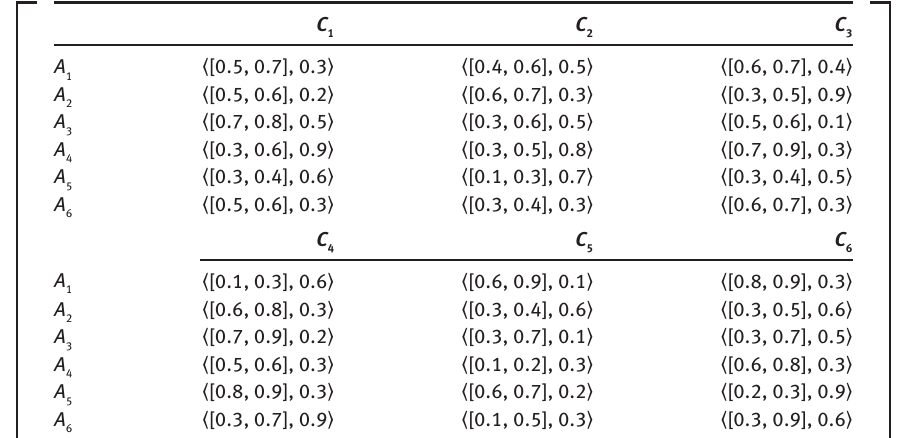
Table 2: Characterization of the Investments of Expert 1.